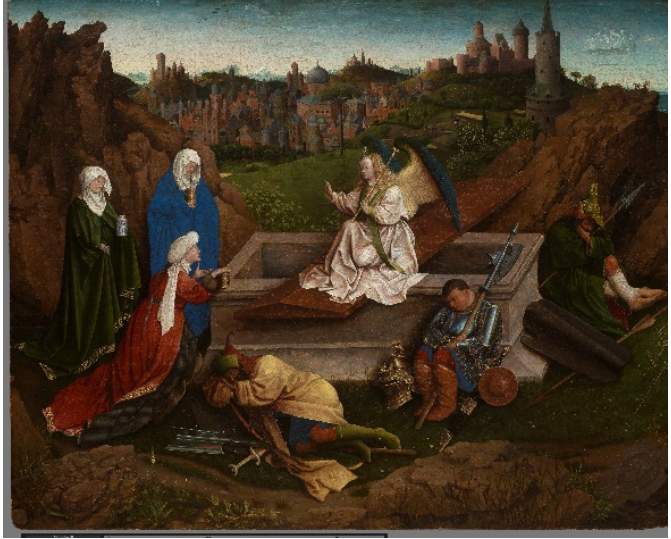
Figure 9. Jan van Eyck, workshop, Three Marys at the Sepulcher , ca. 1440, Rotterdam, Museum van Boijmans Beuningen.